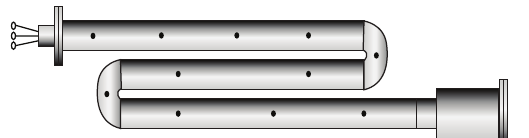
Figure12:ExperimentalsetupofU-bendtubeindicatesthepressure transducer location